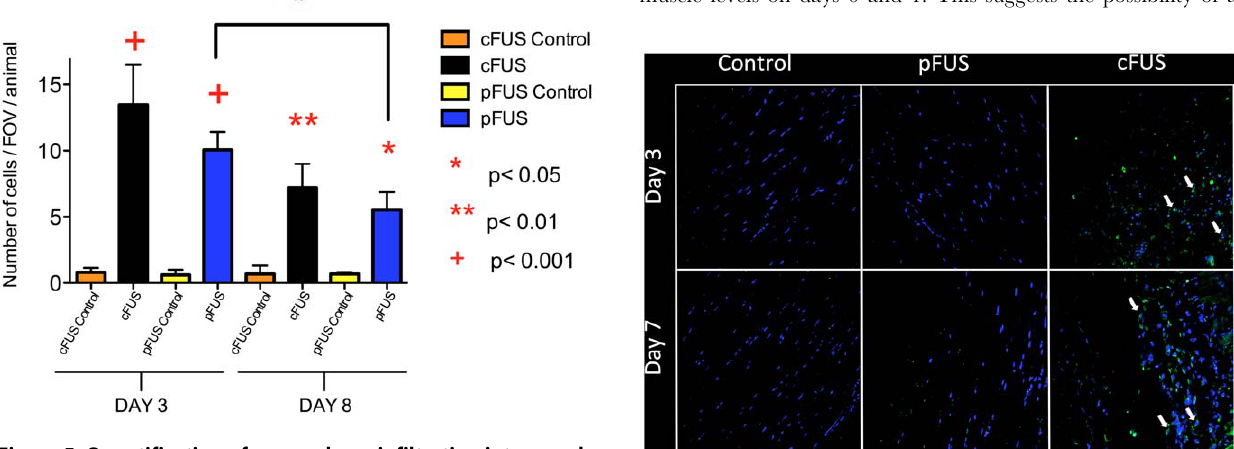
Figure 5. Quantification of macrophage infiltration into muscle following cFUS or pFUS. Muscle tissue treated with cFUS or pFUS showed a greater number of Prussian blue positive macrophages than control tissue on both days 3 and 8 post-FUS (5 FOV/animal, n=3). Statistically similar numbers of macrophages were observed in pFUS- and cFUS-treated tissue on day 3. A significant decrease (p , 0.05) in macrophages is observed between days 3 and 8 in pFUS-treated tissue, but not in cFUS-treated tissue.